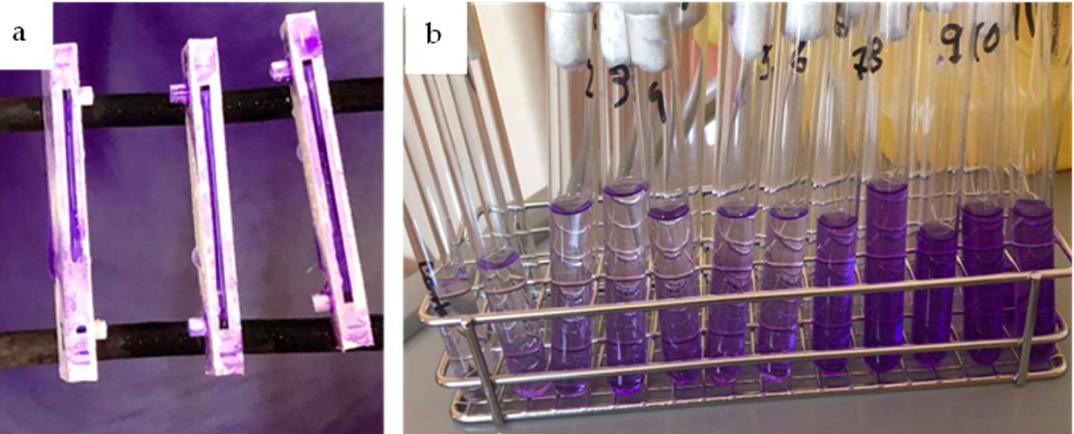
Figure 4. ( a ) Cut side of the microfluidic systems after the crystal violet staining; ( b ) Diluted solutions for UV-Vis investigation.